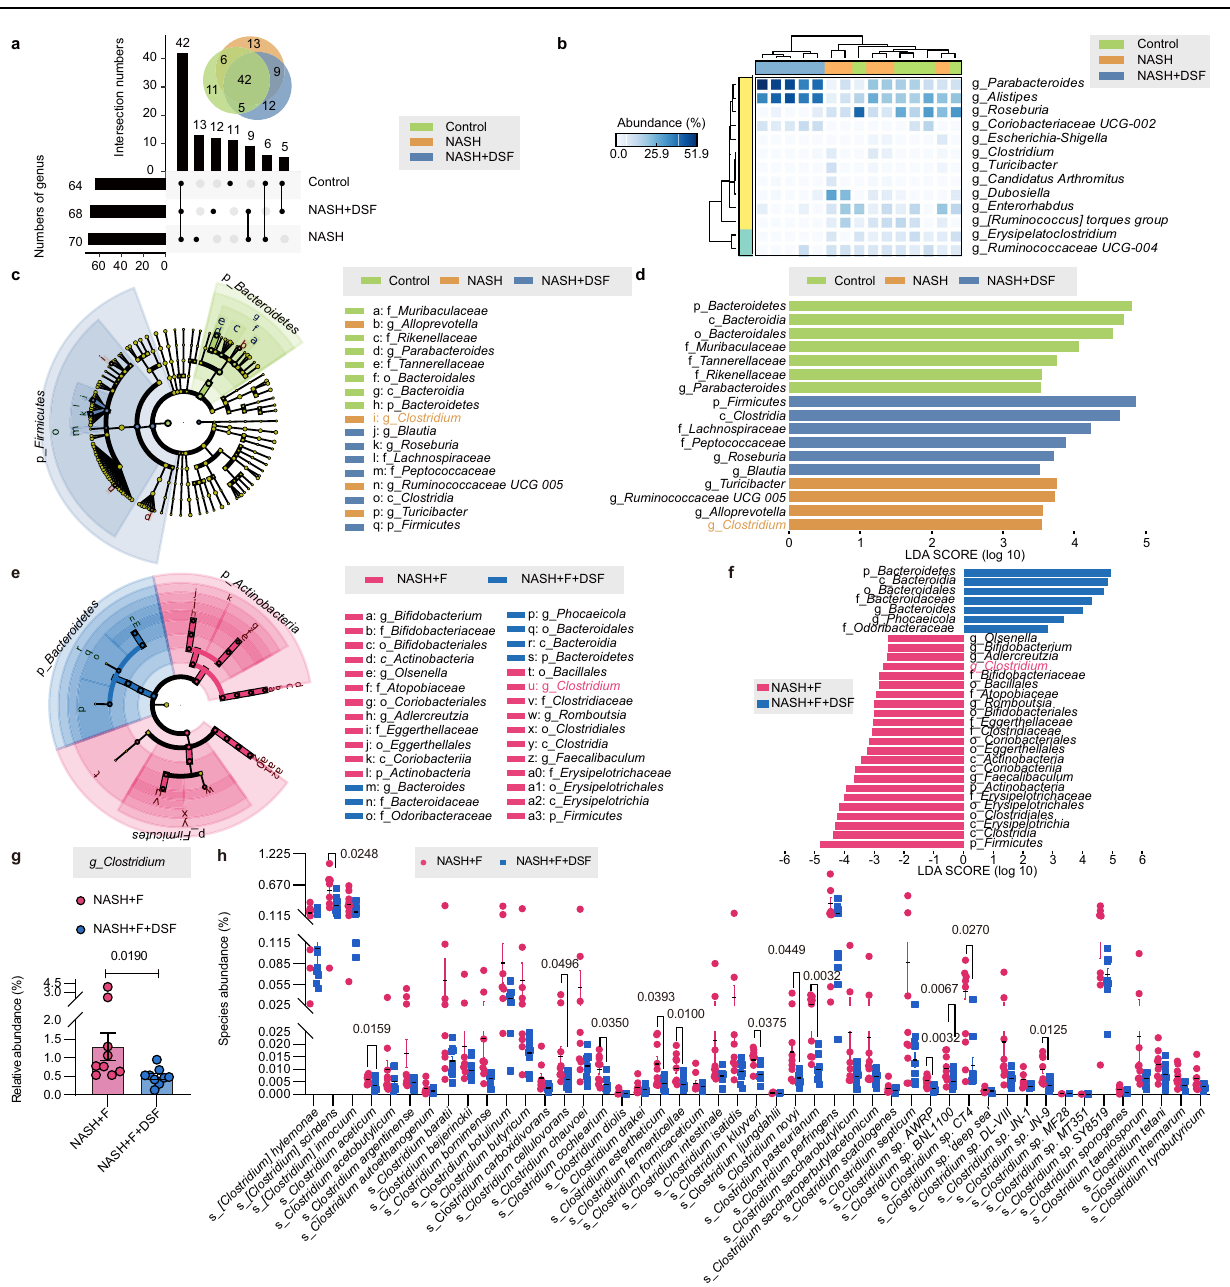
e , f Cladograms generated by LEfSe depicting taxonomic association between microbiome communities from NASH+F and NASH+F+DSF mice (LDA>2.5). Pink bars indicate taxa predominant in NASH+F mice. Blue bars indicate taxa predominant in NASH+F+DSF mice. g The abundance of the genus Clostridium between NASH+F and NASH+F+DSF mice. FDR-adjusted P -value calculated by LinDA was shown. h Different species abundance of Clostridium in NASH+F and NASH+F+DSF mice. FDR-adjusted P -values calculated by LinDA were shown. a – h Each point represented an individual mouse. Data were represented as mean±SEM. DSF disul fi ram, F fecal samples obtained from patients with NASH, LDA linear discriminant analysis, NASH nonalcoholic steatohepatitis. Source data are provided as a Source Data fi